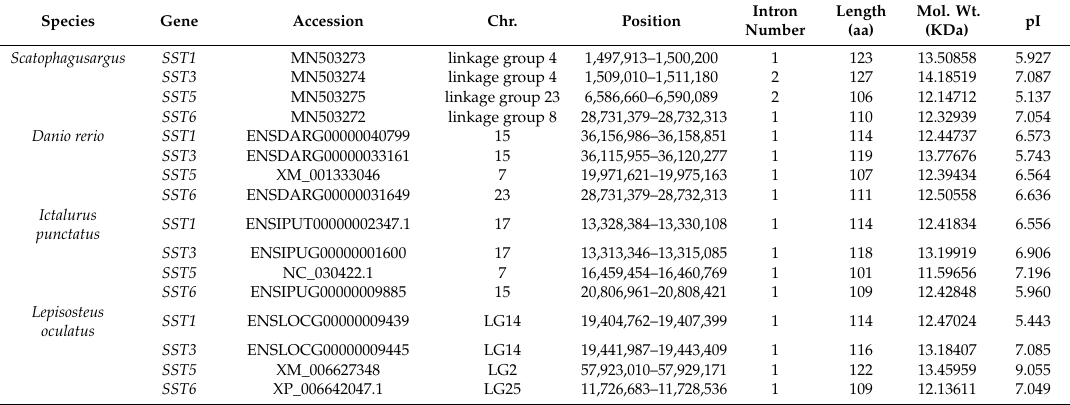
Table 1. The somatostatin family genes and their sequence characteristics in three teleost fish species and the spotted